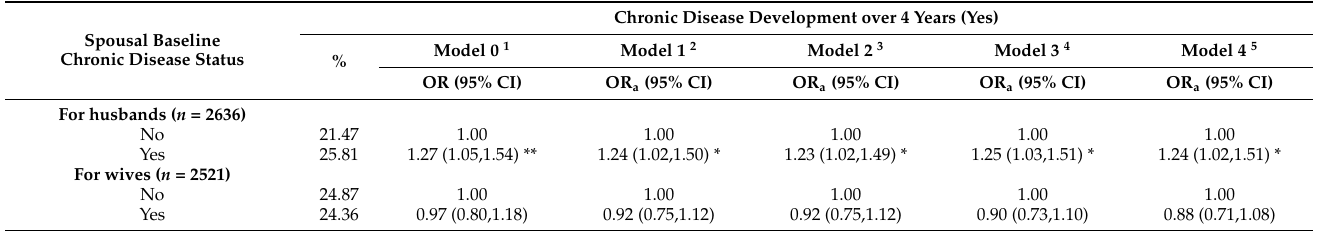
Chronic Disease Development over 4 Years